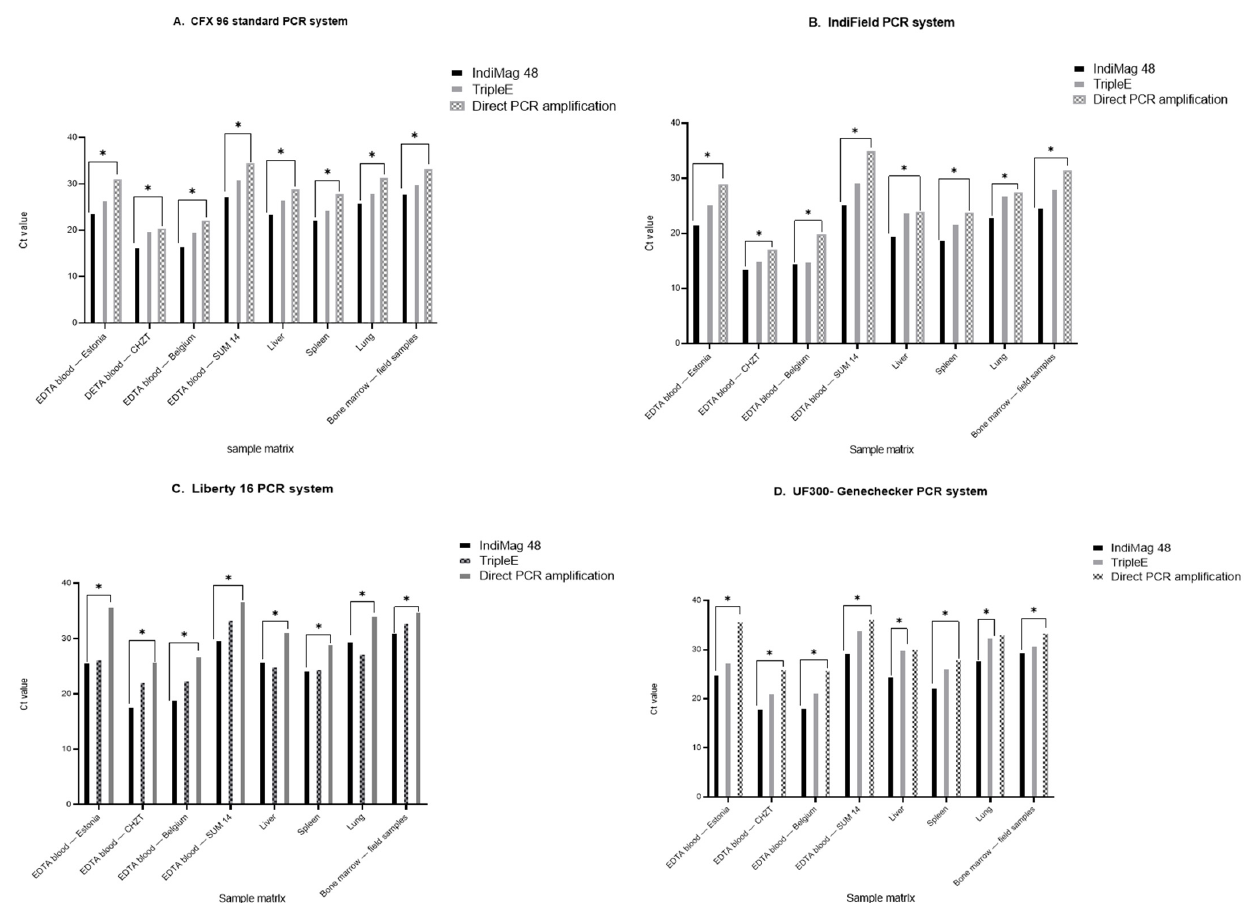
Figure 2. Statistical analyses of the different DNA extraction/releasing methods based on different real-time PCR systems. Based on the different sample matrices, an unpaired t -test was performed to test the significance of the different extraction/releasing methods. The IndiMag 48 and Triple E system showed highly significant Ct values compared to the direct qPCR amplification (* p < 0.01). However, there was no significant difference between the two extraction systems (IndiMag 48 and Triple E ), and this was presented with a p -value > 0.99 (ns). ( A ) Standard deviation (SD) analysis was carried out for all DNA extraction/releasing methods, based on the standard CFX 96 PCR system. The SD value for IndiMag 48 was 4.44, 4.26 for Triple E , and 5.06 for direct PCR. ( B ) Based on the IndiField PCR system, the SD value for IndiMag 48 was 4.40, 5.55 for Triple E , and 5.92 for direct PCR amplification. ( C ) Based on the Liberty16 PCR system, the SD value for IndiMag 48 was 4.95, 4.31 for Triple E , and 4.18 for direct PCR amplification. ( D ) Based on the UF 300-Genechecker system, the SD value for IndiMag 48 was 4.59, 4.83 for Triple E , and 4.18 for direct PCR amplification.